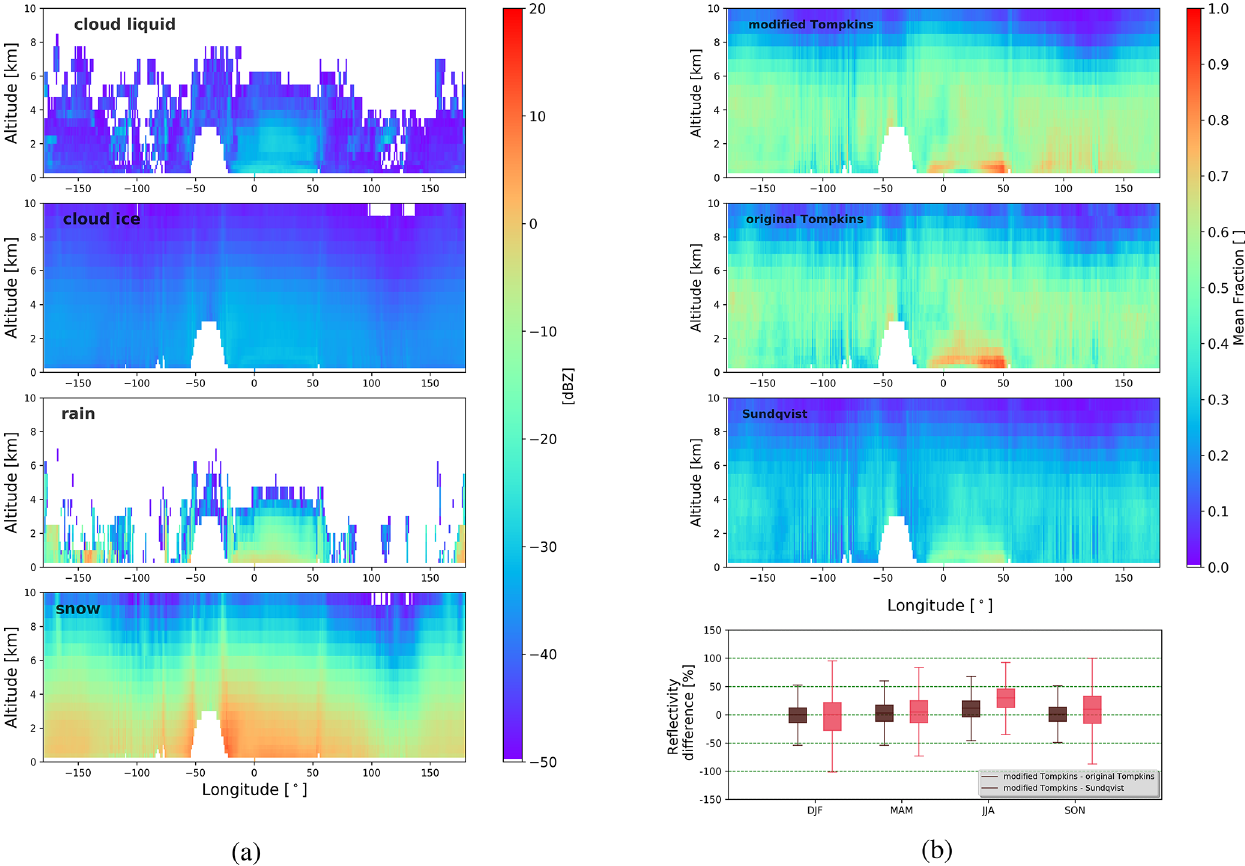
Figure 9. (a) Mean modeled reflectivity with the modified Tompkins scheme separately for all hydrometers (cloud liquid and ice, snow and rain) as a function of altitude for a latitude band 72–73 ◦ N for the winter season (DJF). (b) The three upper panels show the mean fraction of reflectivity contributed by snow with the three different microphysical schemes in the winter season, and the lower panel shows a box plot of the reflectivity differences between the modified Tompkins scheme with respect to the two other schemes (difference from the original Tompkins scheme in brown and that from the Sundqvist scheme in rose) seasonally for snow. The significance of the median difference for both the original Tompkins and Sundqvist schemes from the modified Tompkins scheme is shown to be statistically robust for all seasons performing the Student’s t test with random samples (10% of the total amount) of the modeled difference